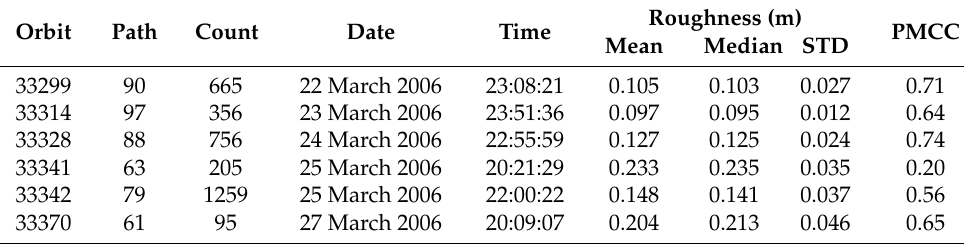
Table 6. Comparative assessment of MISR-derived roughness against a roughness from independent pre-IceBridge (March 2006) aerial campaigns, where PMCC is product motion correlation coefficient, p < 0.001 for all scenes except Orbit 33341 where p <